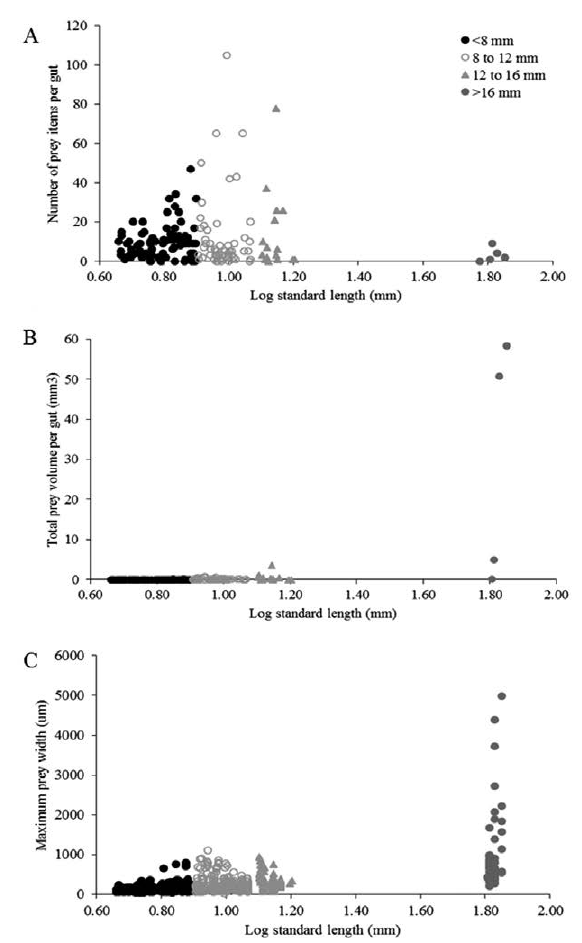
Fig. 6. – Relationship between feeding success and size of the indi- viduals of S. sanguineus : A, number of prey items per gut (PIPG) and standard length (SL); B, total prey volume per gut (TPVG) and SL; and C, maximum prey width (MPW) and SL.